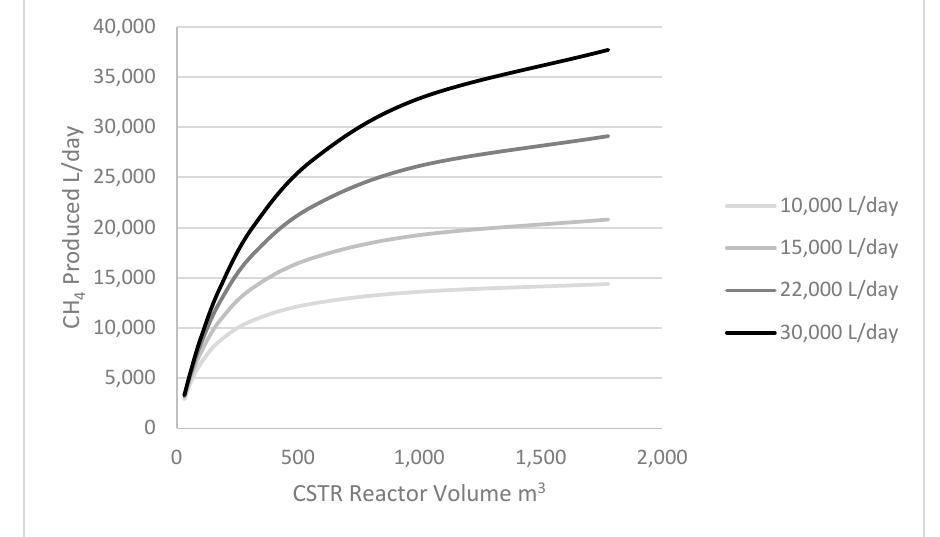
Figure 3. Daily methane production at different volumes and feed flow rates.